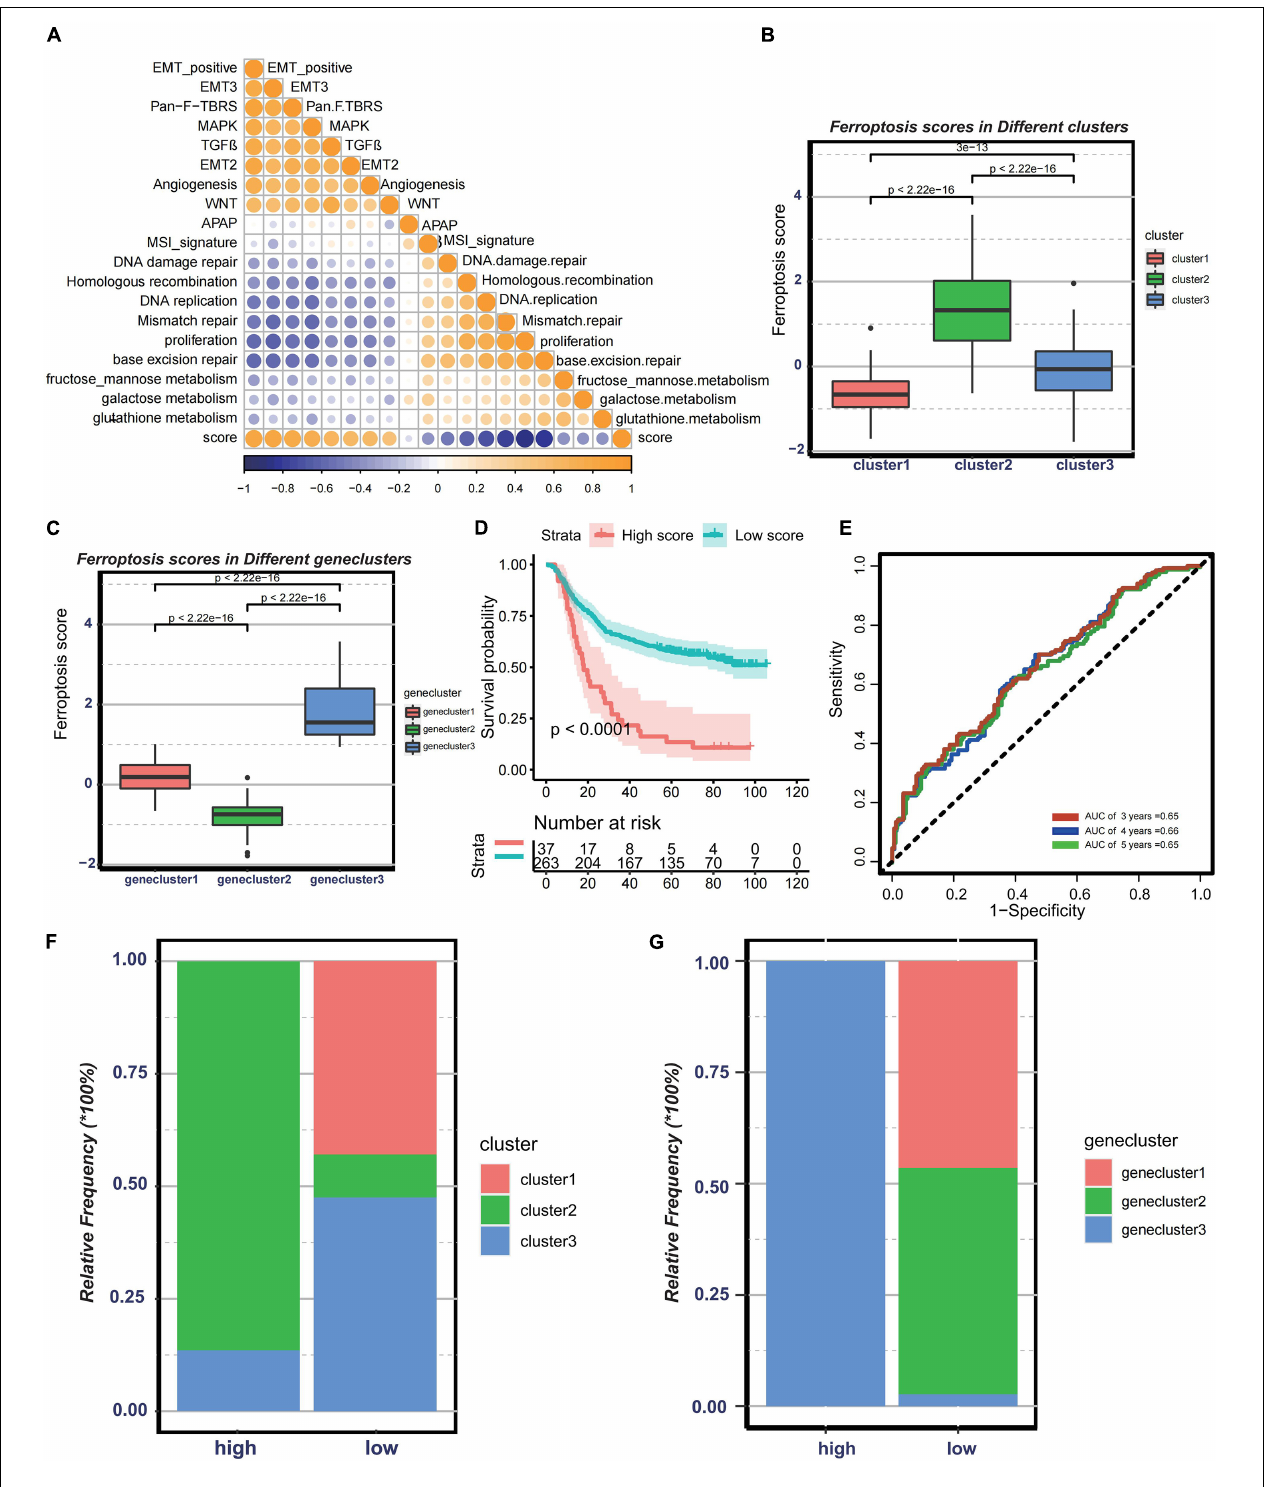
FIGURE 5 | Construction of ferroptosis gene signatures. (A) Correlation between known gene signatures related to gastric cancer and the ferroptosis score. (B) Differences in the ferroptosis scores among three distinct clusters. (C) Differences in the ferroptosis scores among three distinct gene clusters. (D) Kaplan–Meier analysis of patients with low or high ferroptosis scores. (E) Prognostic value of the ferroptosis score in the Asian Cancer Research Group (ACRG) cohort. (F) Relative frequency of clusters in patients with low or high ferroptosis scores in the ACRG cohort. (G) Relative frequency of gene clusters in patients with low or high ferroptosis scores in the ACRG